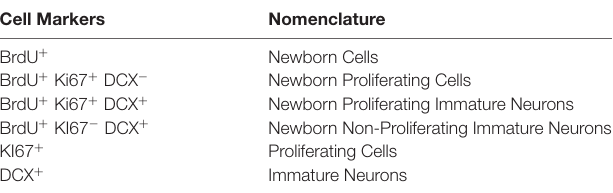
TABLE 1 | Table showing the nomenclature used to describe cells at different stages of neurogenesis marked by the expression of specific markers. Cell